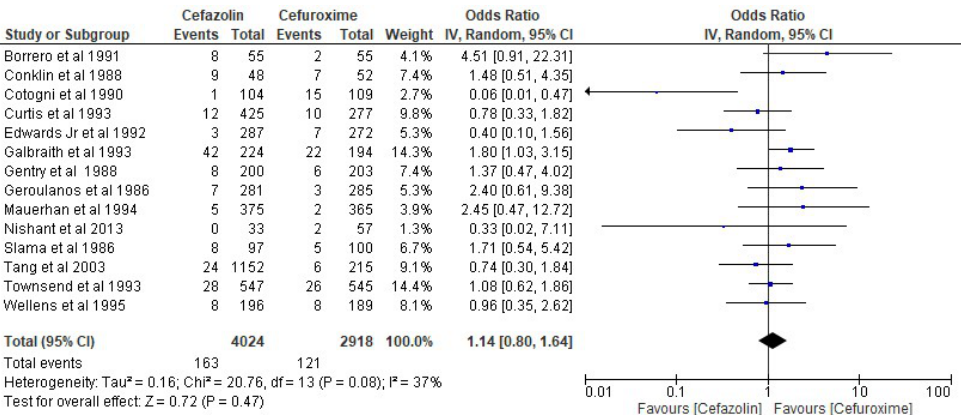
Figure 2. The rate of SSIs in the cefazolin group vs. other cephalosporins. The included studies